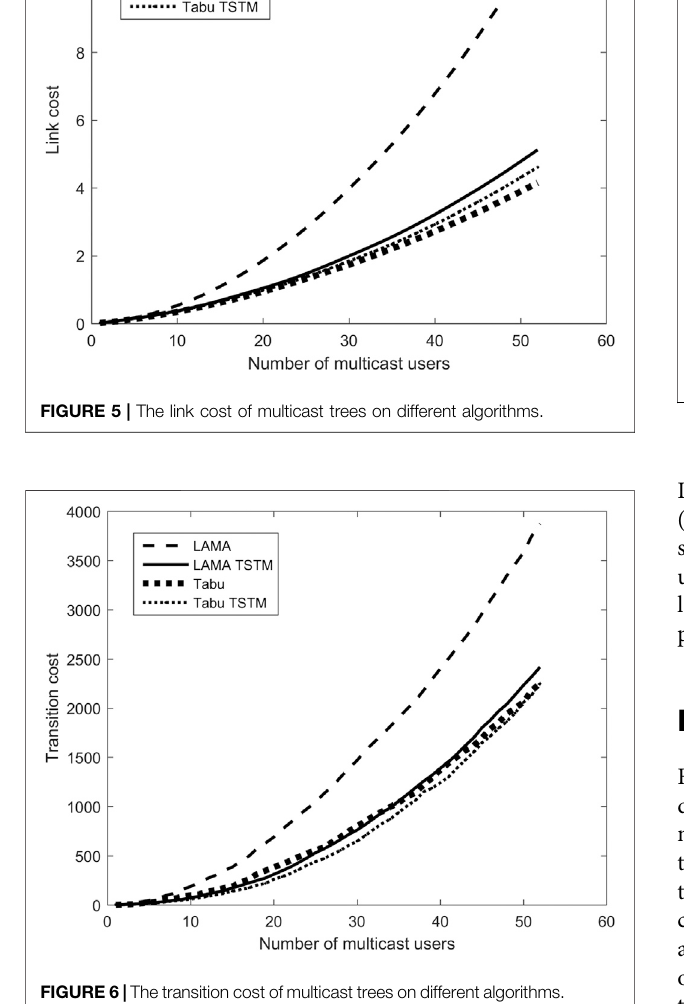
FIGURE 6 | The transition cost ofmulticast trees on different algorithms.